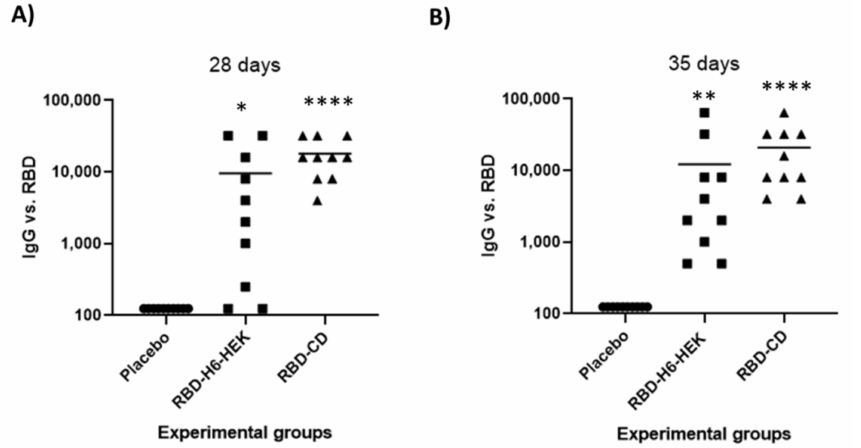
Figure 9. Comparison of immunogenicity between RBD-CD and RBD-H6-HEK in mice. The mice were divided into three experimental groups of ten mice each, one group immunized with 10 µ g of RBD-CD, a second group immunized with RBD-H6-HEK, and a negative control that was immunized with PBS. Booster was done at 21 days after the first immunization. Mice sera were collected on day 0 (pre-immune serum) and at 28 ( A ) and 35 ( B ) days after starting the experiment to evaluate specific IgG titers by ELISA. Serum was diluted starting from 1:250. A Kruskal–Wallis and Dunn ´ s multiple comparison tests were performed. Asterisks represent statistically significant differences (*) p < 0.05, (**) p < 0.01, (****) p < 0.0001.